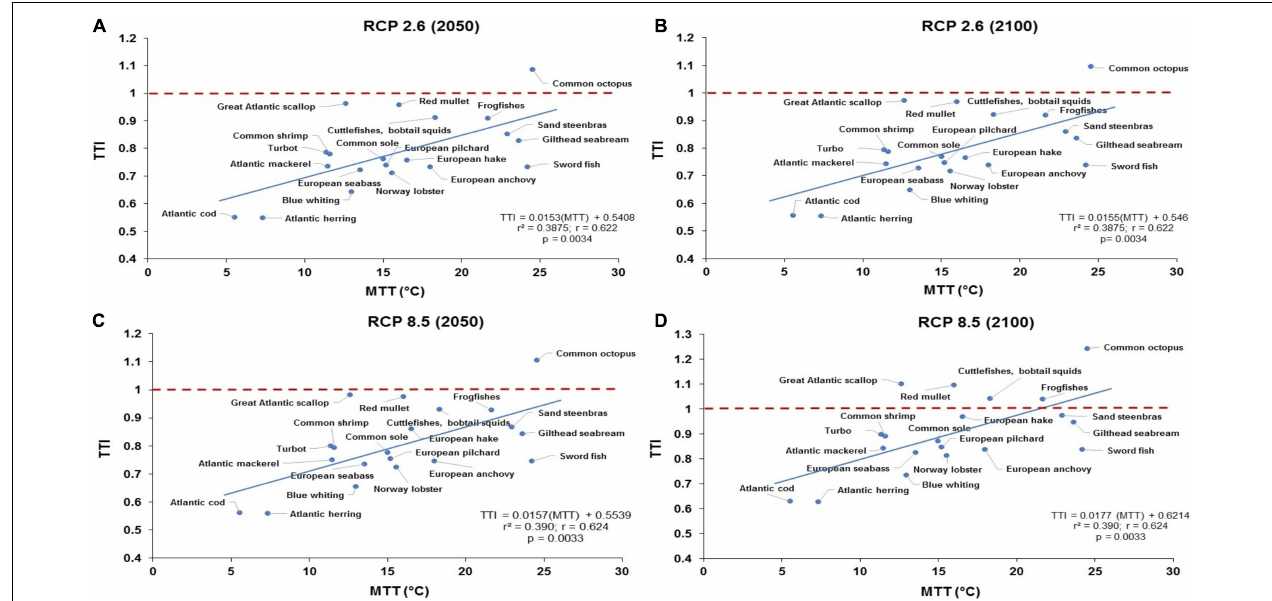
) for all fish species assessed vs. the species-specific MTT under RCP 2.6 (i.e., low FIGURE 3 | The relationship between the estimated TTI ( TTI = ( MTP + MTP ∗ (cid:52) T ) T MAX CO 2 emission/high mitigation scenario) for (A) 2050 and (B) 2100; and RCP 8.5 (high CO 2 emissions or business-as-usual) for (C) 2050 and (D) 2100. The relationship between TTI and MTT under RCP 8.5 shows that most temperate pelagic and benthopelagic species will be affected either by high SST under RCP 8.5 by 2100 (D) , as an indication of high sensitivity of exposure to ocean